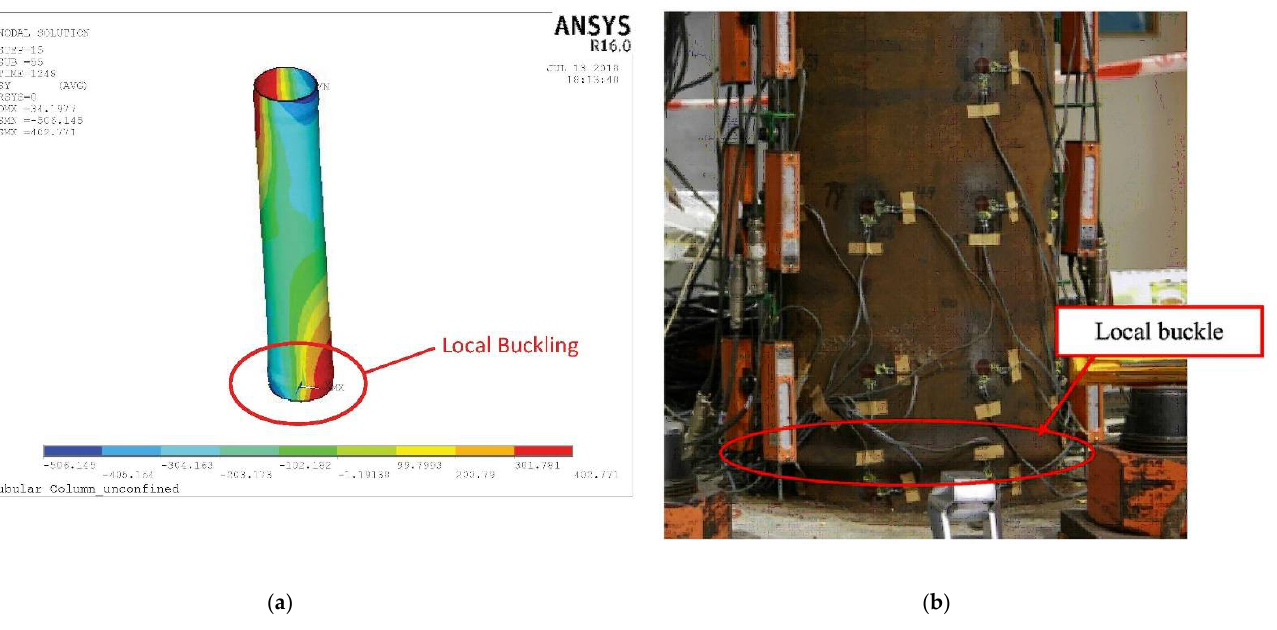
Figure 5. Deformed shapes: ( a ) NLFEA and ( b ) result LCFT-0-106-F. Reprinted from Yu et al. [32] .